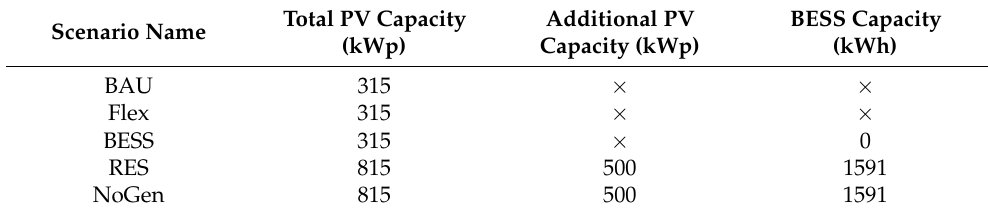
Table 6. PV and BESS optimal capacity results with lower diesel price.